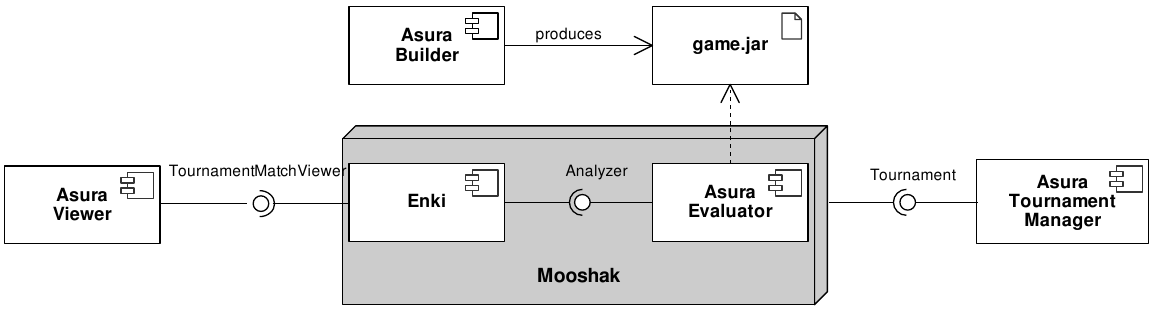
Figure 1. Architecture of the proposed ecosystem of